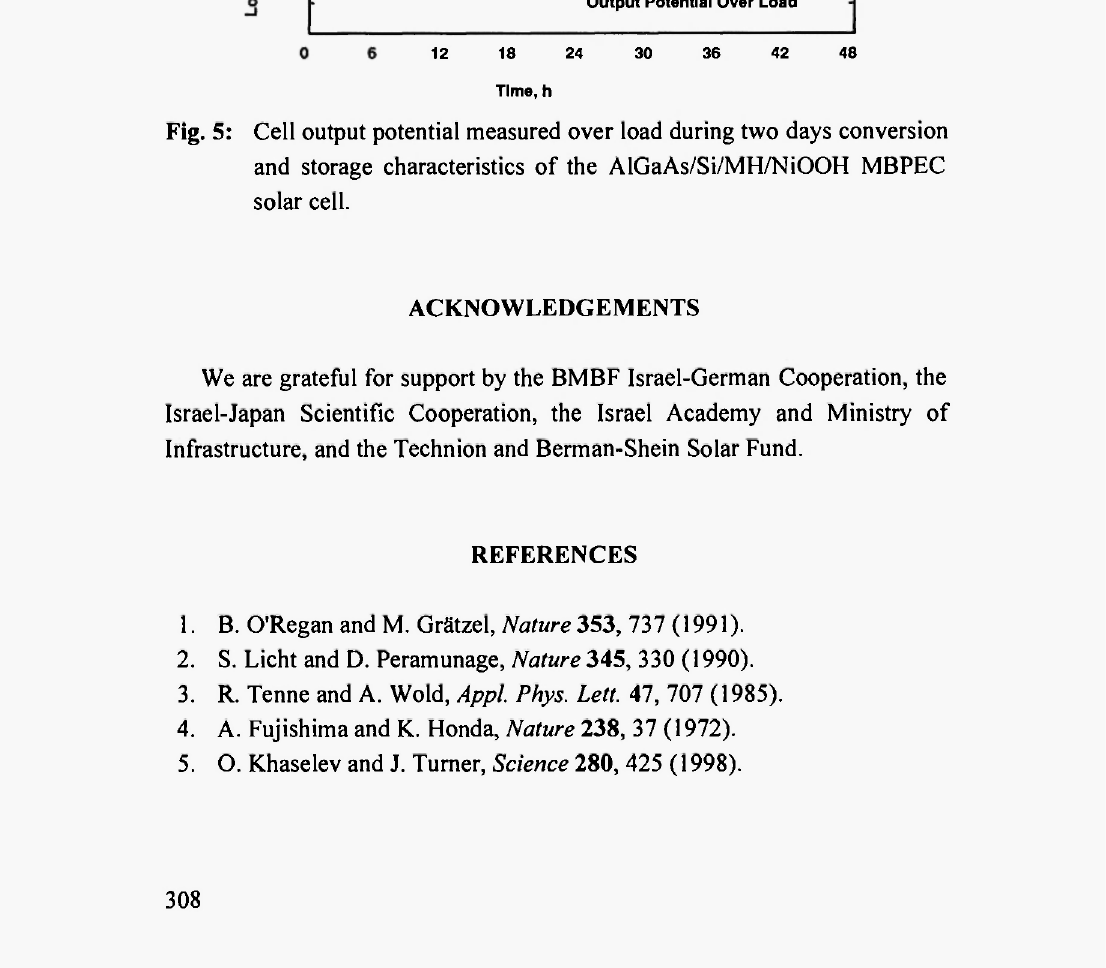
Time, h Fig. 4: Storage current during two days conversion and storage characteristics of the AlGaAs/Si/MH/NiOOH MBPEC solar cell. 1.5